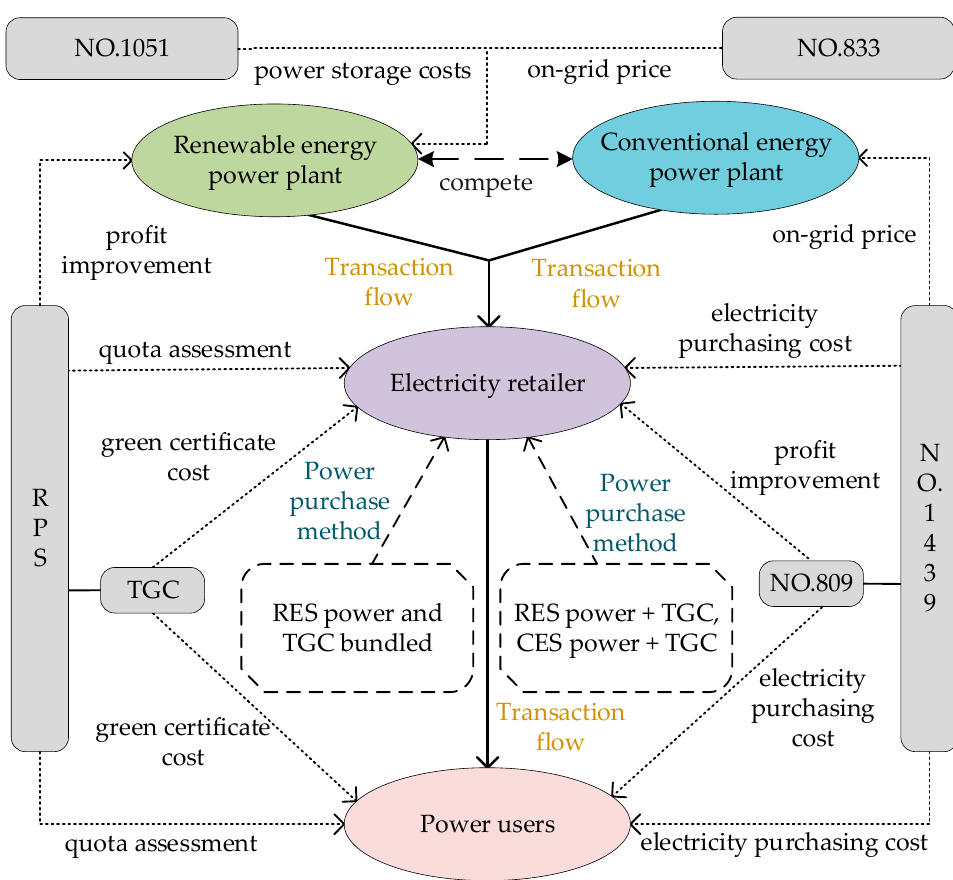
Figure 2. The impact of the new policies on electricity trading